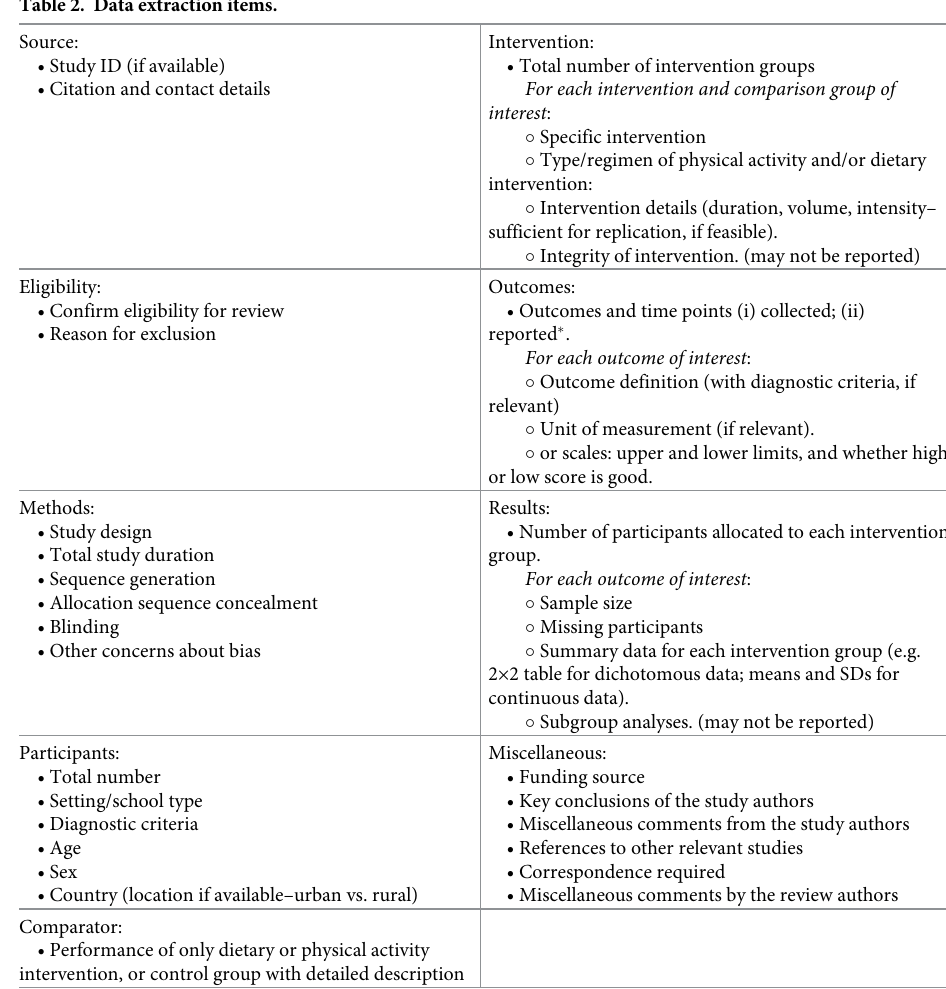
Table 2. Data extraction